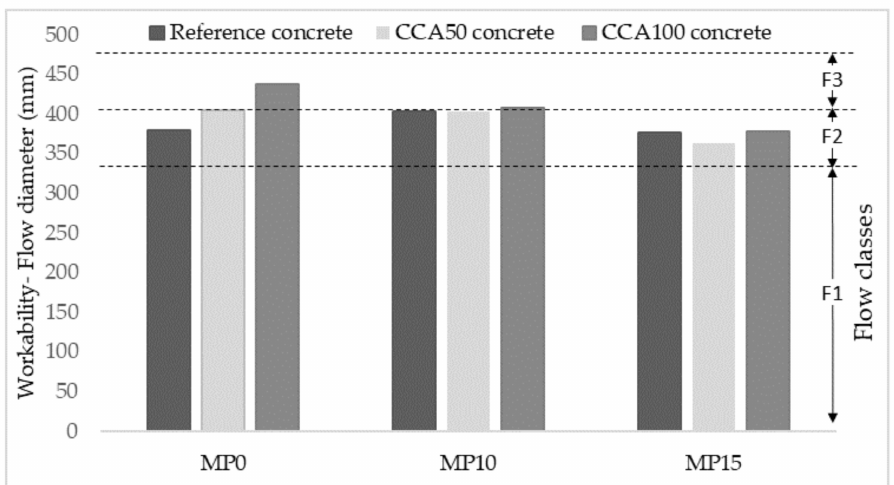
Figure 5. Workability of concrete mixes and standardized flow classes.